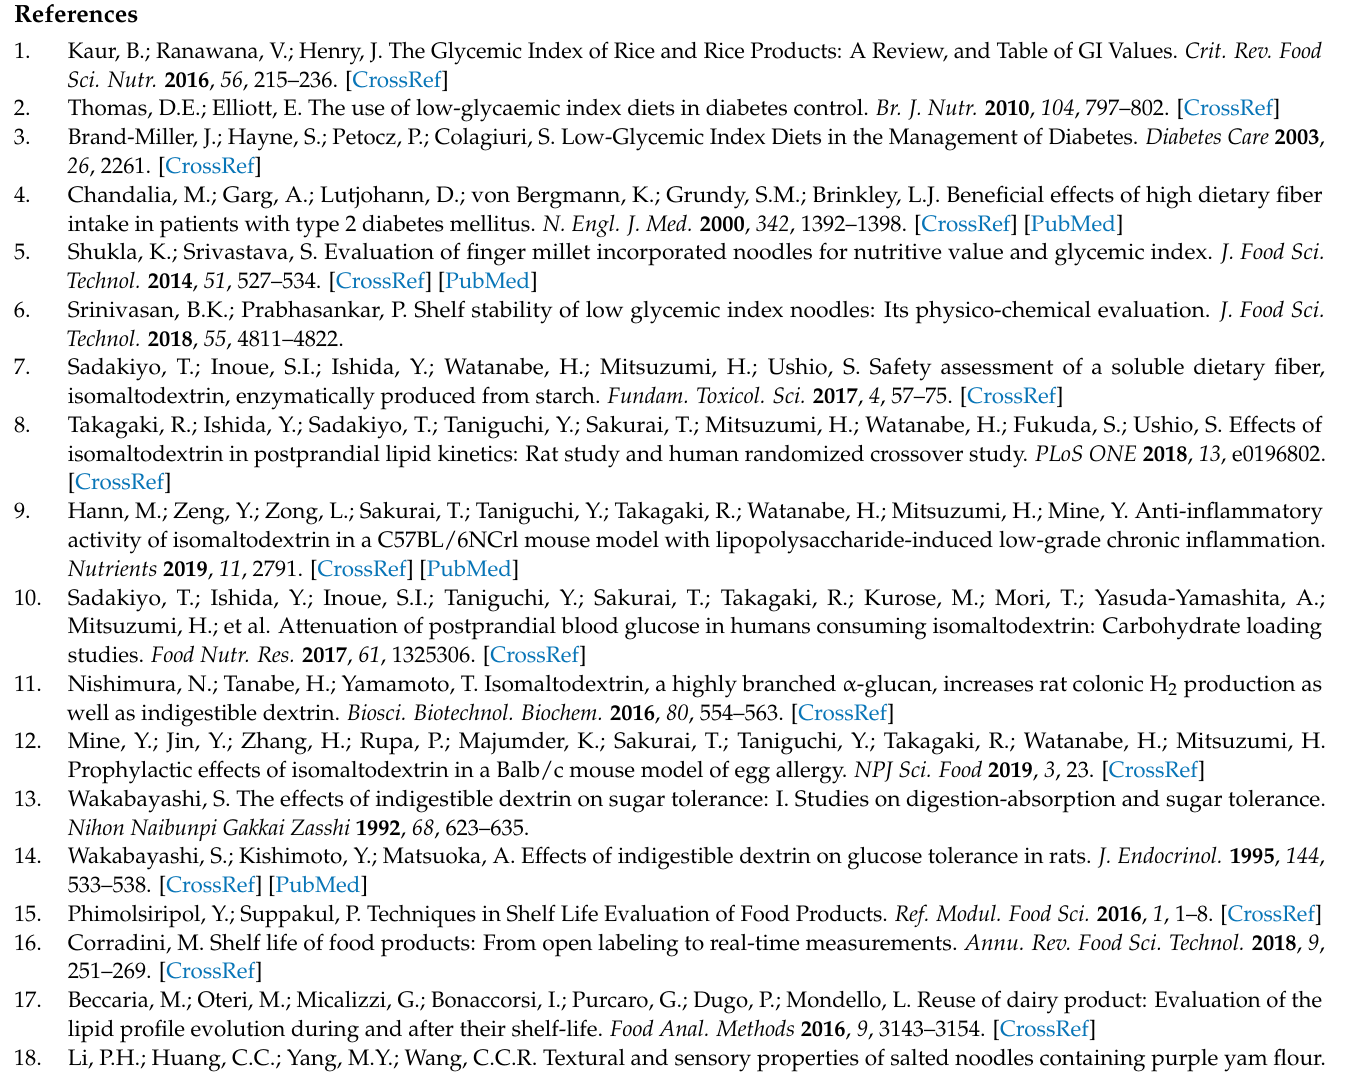
Supplementary Materials: The following are available online at https://www.mdpi.com/2223-7 747/10/3/578/s1, Figure S1. Storage stability study design of wheat noodles incorporated with isomaltodextrin, Table S1: Changes in indigestible dextrin (ID), resistant starch, IHMWDF, and SHMWDF of wheat noodles with maltodextrin during different storage period at 25 ◦ C storage temperature, Table S2: Changes in indigestible dextrin (ID), resistant starch, IHMWDF, and SHMWDF of wheat noodles with maltodextrin during different storage period at 4 ◦ C storage temperature. Table S3: Changes in indigestible dextrin (ID), resistant starch, IHMWDF, and SHMWDF of wheat noodles with maltodextrin during different storage period at − 20 ◦ C storage temperature. Table S4: Changes in indigestible dextrin (ID), resistant starch, IHMWDF, and SHMWDF of wheat noodles with maltodextrin during different storage period at 40 ◦ C storage